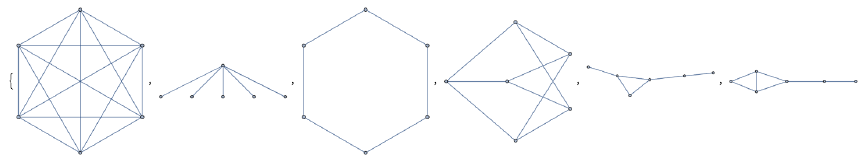
Figure 6. Graph representation of Q [2]